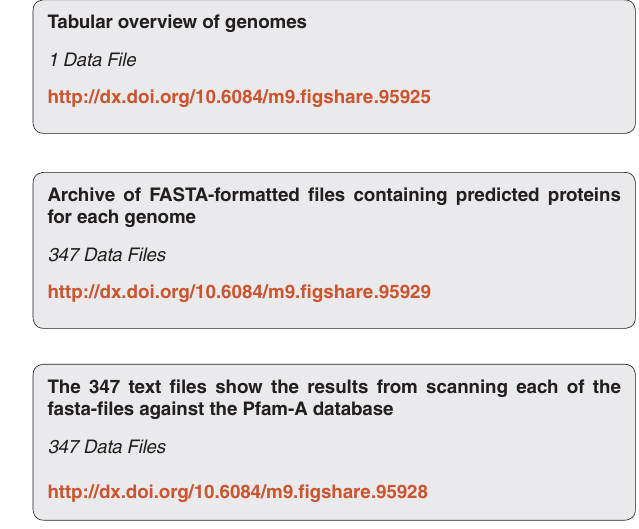
Figure 4. Effect of significance cutoff. The horizontal axis is the – log E = 10 -15 on the right. The blue curve shows how the number of core families drops by stricter cutoff (going from left to right), and the red curve similar for the number of ORFan